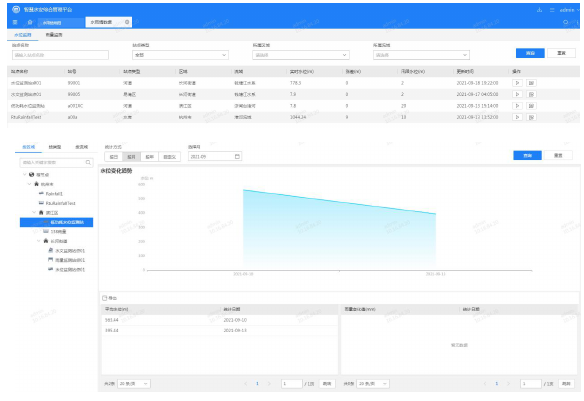
Figure 12 . Monitoring data management